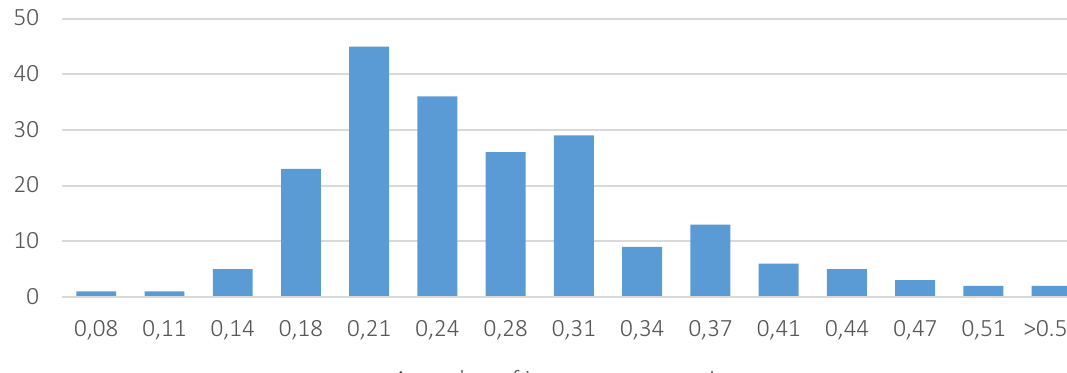
Figure 1. Distribution of insurance companies according to the integrated indicator of competitiveness on the travel services